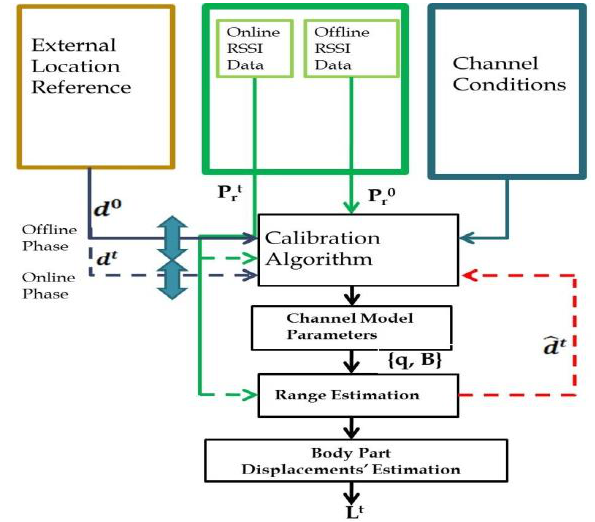
Figure 1. RSSI based Body part tracking scheme. Offline calibration phase produces the channel model parameters. The RSSI measurements and the channel model parameters are used to estimate the body part displacements over